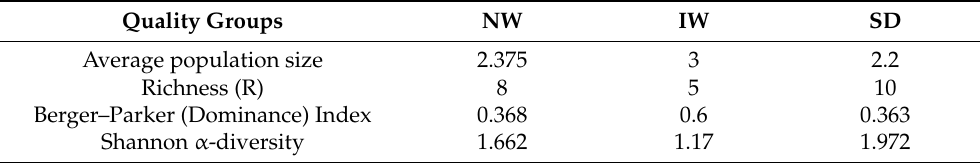
Table 2. Bacterial biodiversity characteristics of the pre-established groups of ram semen samples.